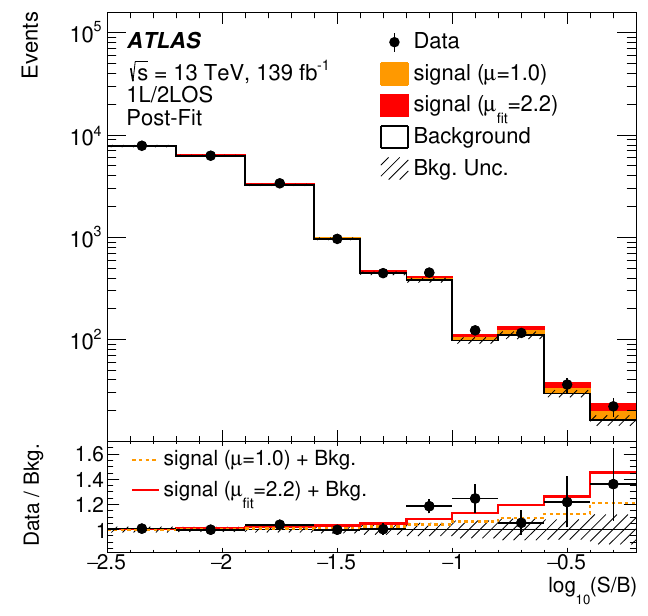
Figure 10 . Observed and expected event yields as a function of log ( S/B ) , where S and B 10 are the post-fit signal and total background yields, respectively. The bins in all fitted regions are ordered and grouped in bins of log ( S/B ) . The signal is shown for both the best-fit signal strength, 10 µ = 2 . 2 , and the SM prediction, µ = 1 . 0 . The lower panel shows the ratio of the data to the post- fit background prediction, compared with the signal-plus-background prediction with the best-fit signal strength and the SM prediction. The shaded band represents the total uncertainty in the background